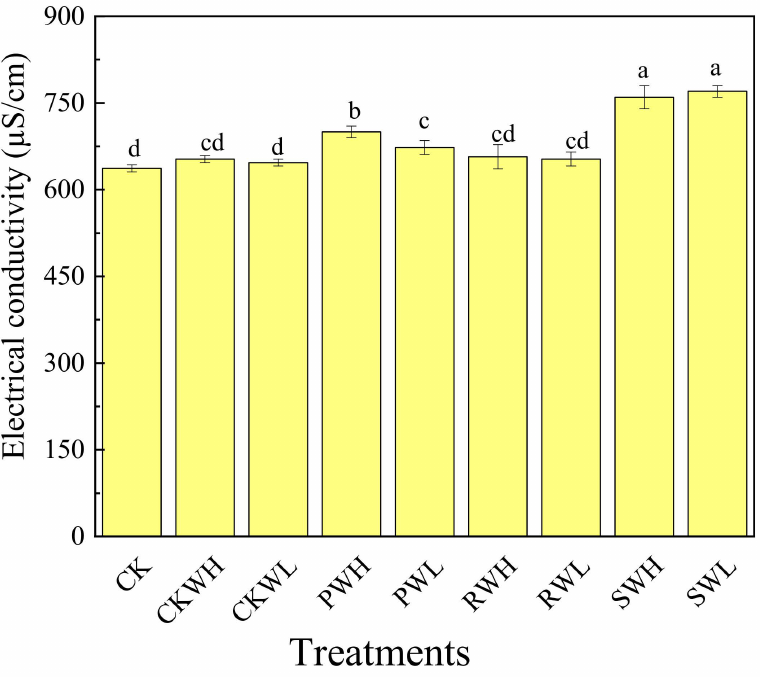
Figure 1. Effects of different irrigation treatments on soil electrical conductivity. Note: control (CK): groundwater; PW: piggery wastewater; RW: reclaimed water; SW: saline water; H: 300 kg/ha nitrogen application; L: 200 kg/ha nitrogen application. Different letters indicate a significant level of 5% between the different treatments. Table 4. ANOVA analysis for effects of different irrigation treatments on soil